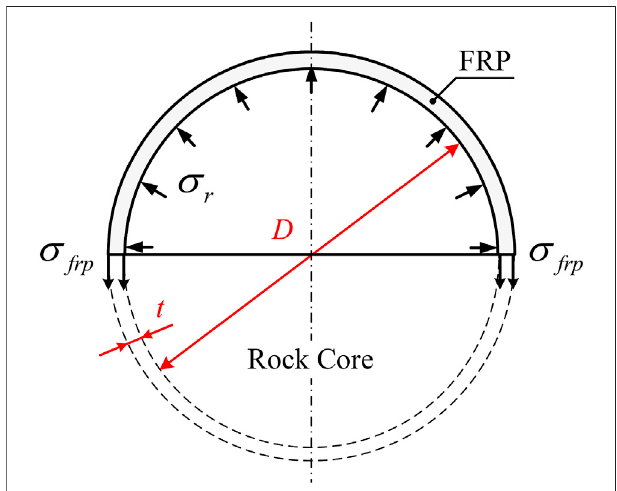
FIGURE 1 | Analytical model of con fi ning stiffness of